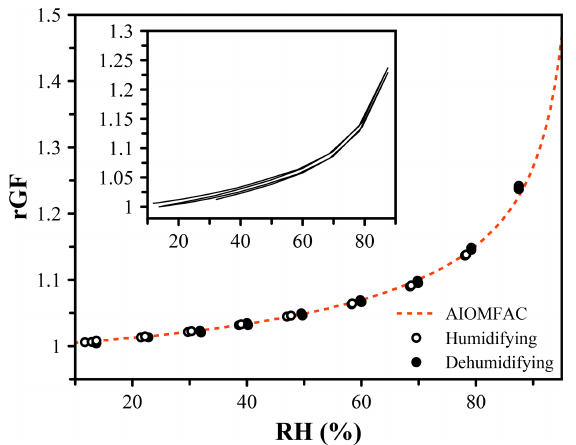
Figure 6. Hygroscopic growth of 1,2,6-hexanetriol, an organic molecule with a vapor pressure of 0.20 ± 0.02mPa (Cotterell et al., 2014), leading to evaporation over the course of the measurement. The dry size (at 0% RH) was updated each cycle to achieve agree- ment with the AIOMFAC prediction (red). A fixed dry size was used in the inset, indicating the influence of a decreasing dry size on the predicted growth